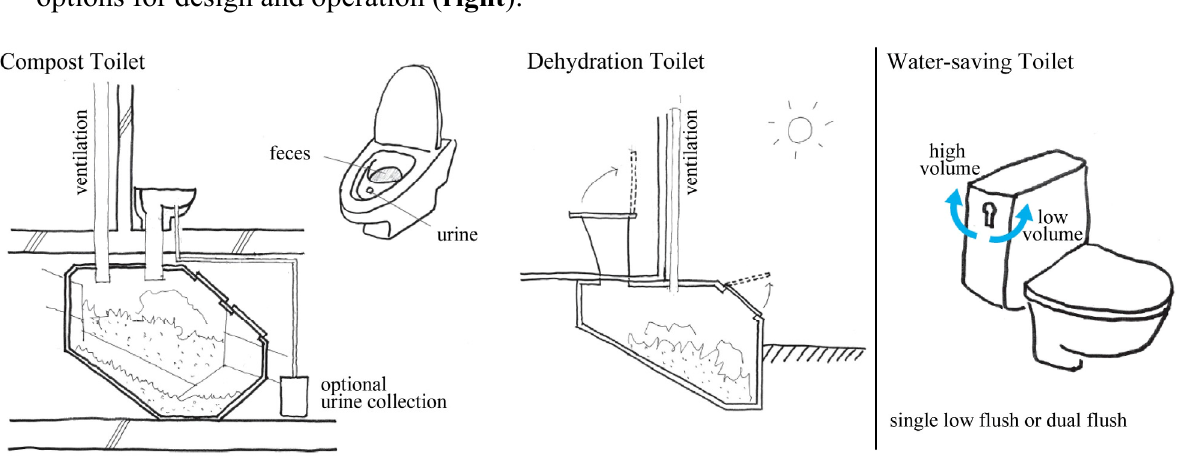
Figure 1. Illustration of different waterless toilet types ( left ), and a water-saving toilet with options for design and operation ( right